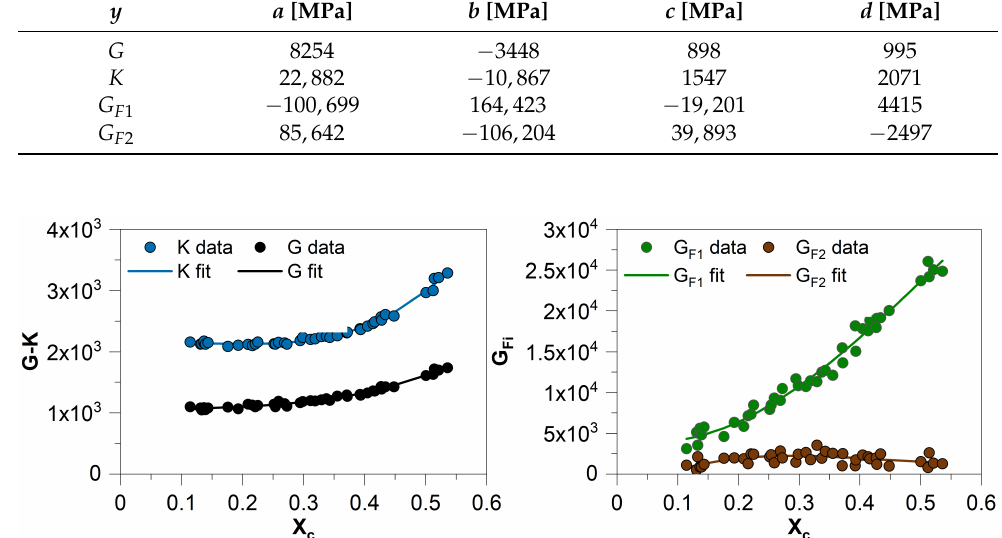
Figure 11. Data and associated fit for the dependence of the material parameters on the degree of